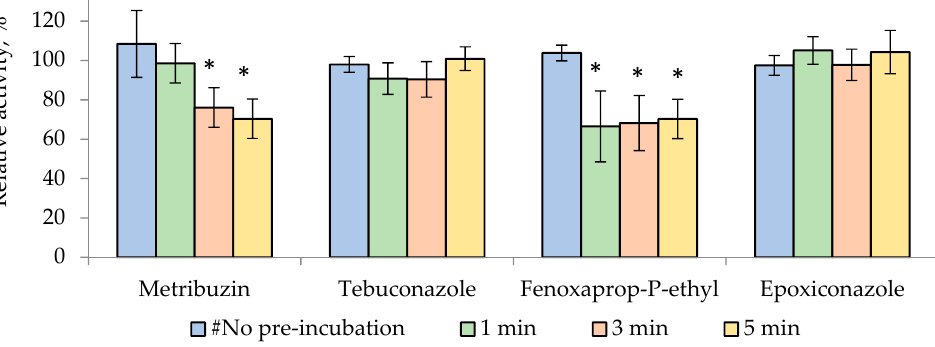
Figure 2. Dependence of relative activity of trypsin on the time of incubation of the enzyme in solutions with pesticide concentration of 9 mg/L. A 20% inhibition of trypsin activity was achieved by pre-incubation of trypsin in metribuzin and fenoxaprop-P-ethyl solutions for 3 and 1 min, respectively. #No pre-incubation denotes that the pesticide solution was added to the reaction mixture immediately before signal detection. * Values of p < 0.05 when comparing the relative activity values obtained without pre-incubation of trypsin in the pesticide solution.